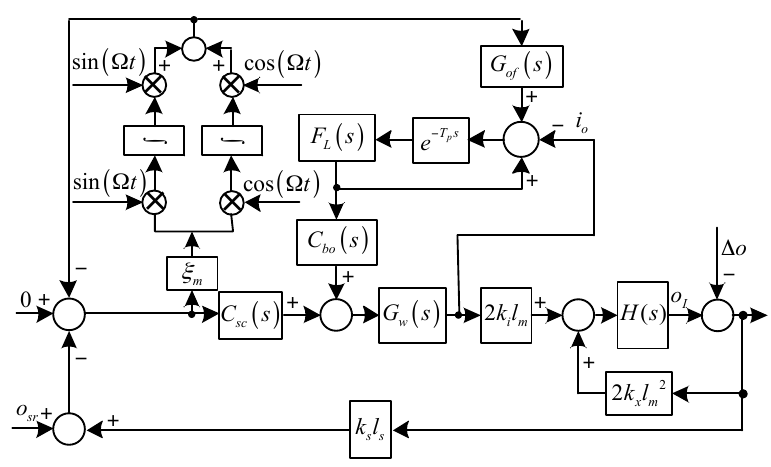
Figure 6. Diagram of the rotational system with harmonic torque elimination.